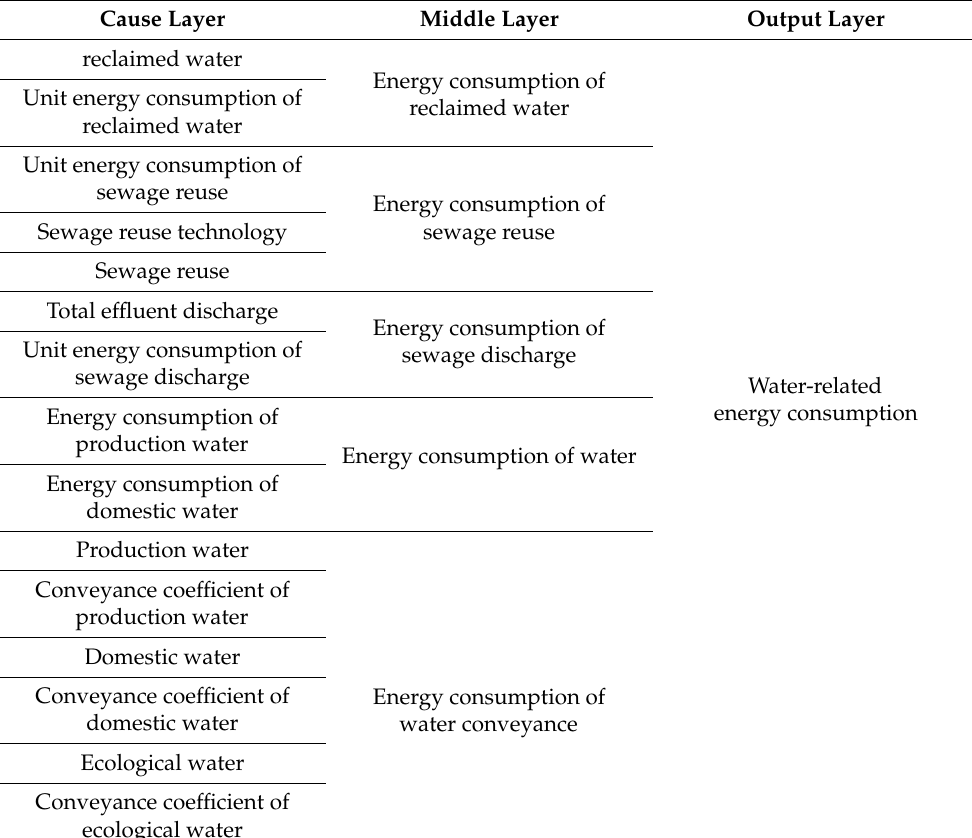
Table 4. Cause hierarchy for the water-related energy